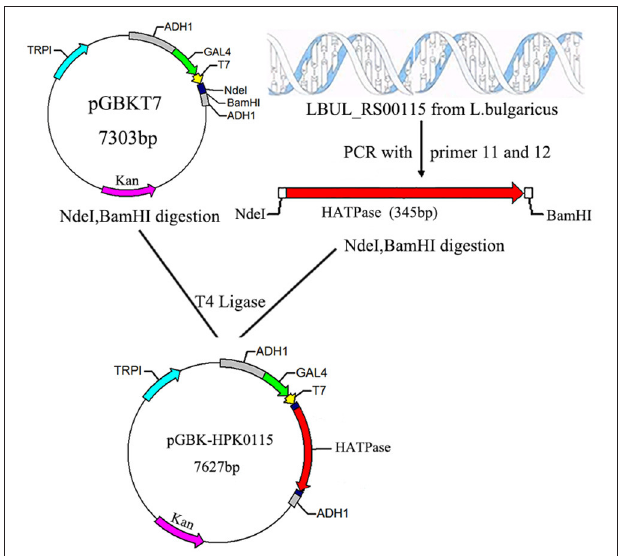
FIGURE 4 | Construction of recombinant plasmid pGAD-RR0110. The red arrow represents the LBUL_RS00110 gene fragment from L. bulgaricus ATCC BAA-365; The magenta arrow represents the ampicillin resistance gene; NdeI, BamHI are endonuclease hydrolysis sites.